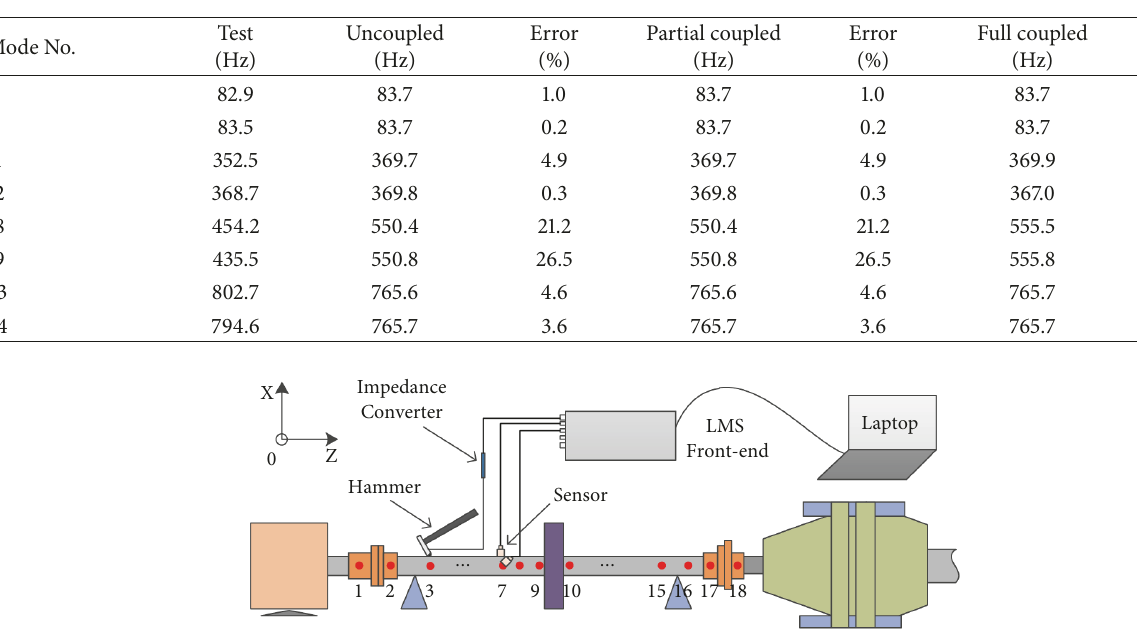
Figure 16: Schematic of modal test system.